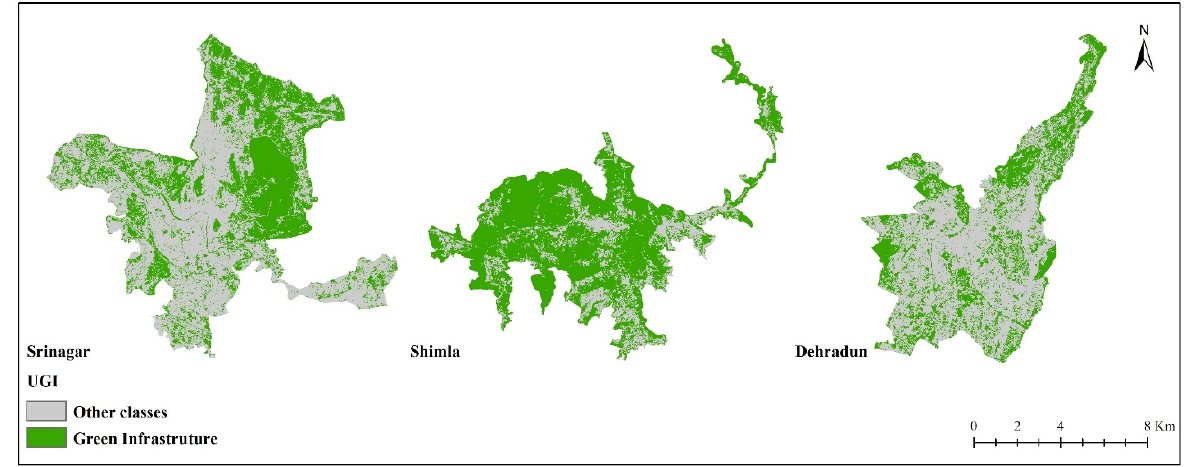
Figure 2. Distribution of UGI in three cities.